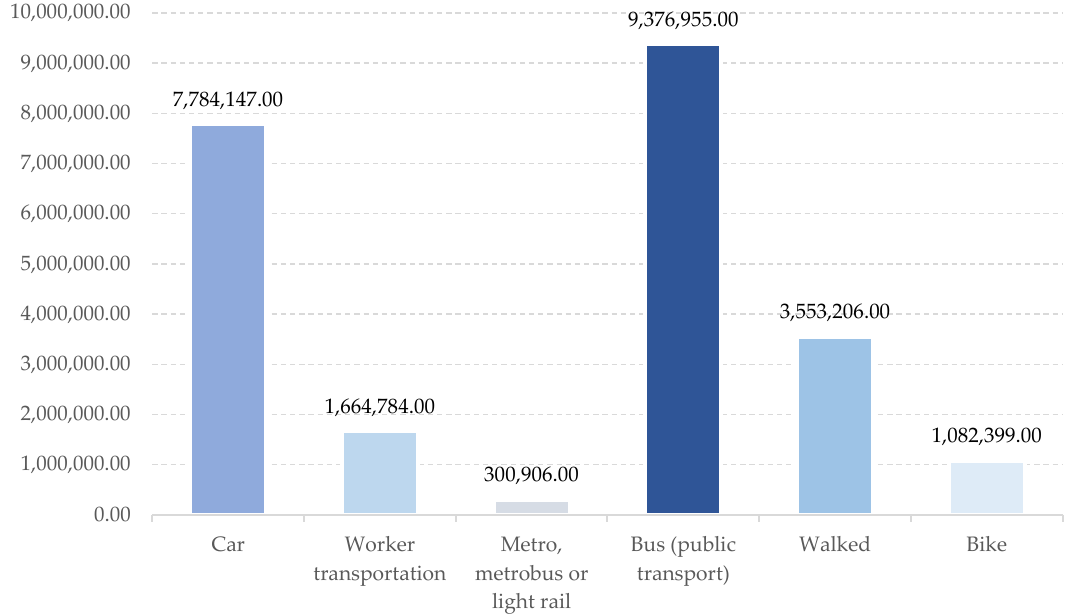
Figure 3. Main means of transport used by the occupied population.